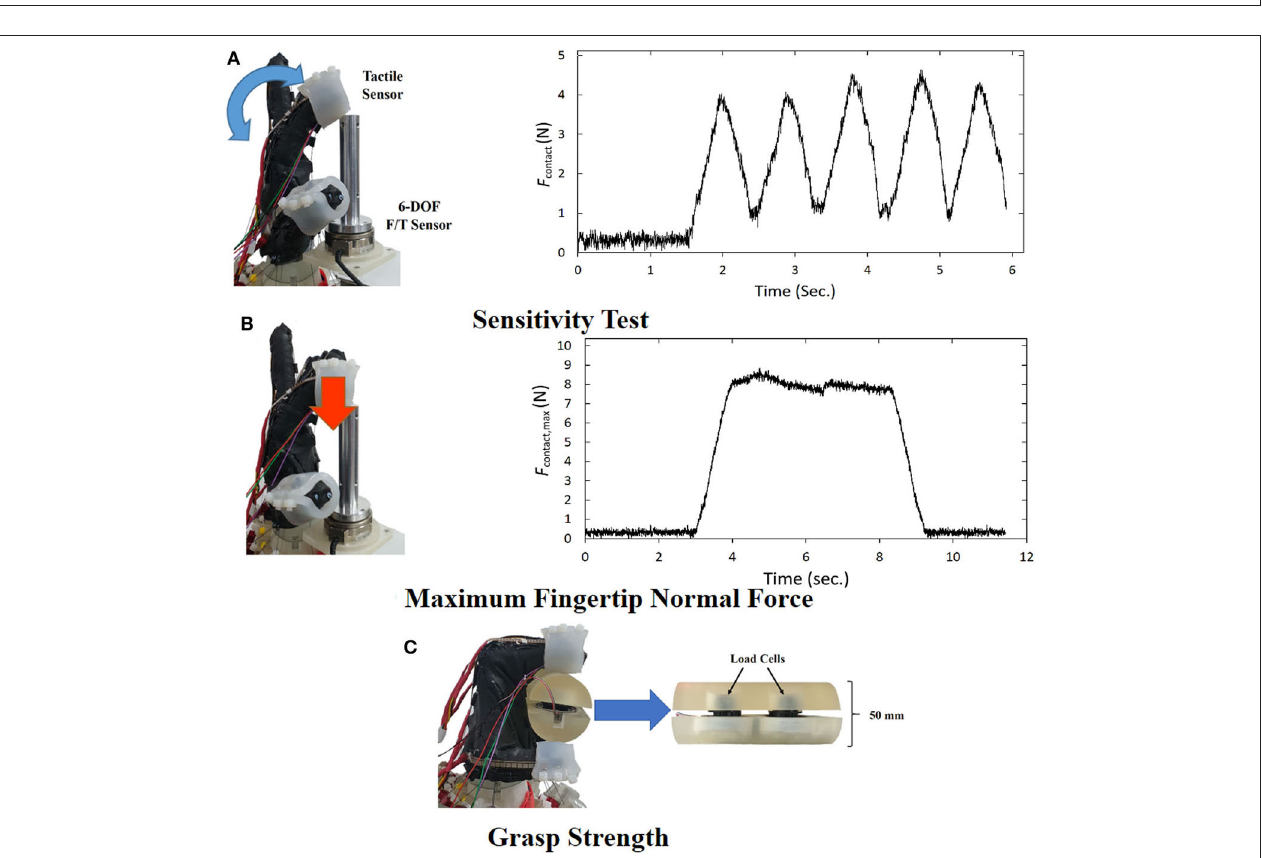
FIGURE 8 | Three standard grasp performance tests. (A) Sensitivity test setup (left) and the contact force measurement result. (B) Maximum fingertip contact force measurement setup (left) and the force measurement result (right) (C) Grasp measurement setup with the custom-built grasp force measurement device.